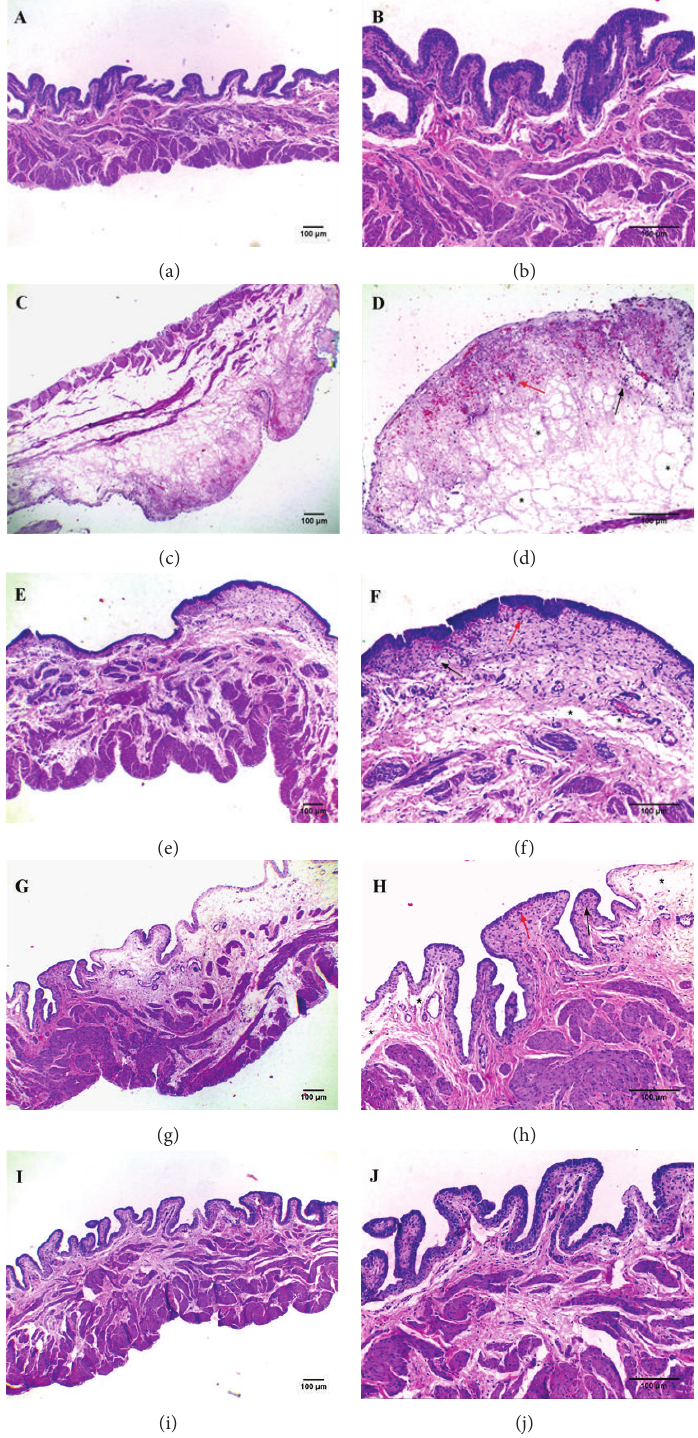
Figure 3: Light microscopy of the bladders of rats with cystitis. Original magnification of 10-fold (Panels (a), (c), (e), (g), and (i)) or 40- (Panels (b), (d), (f), (h), and (j)); hematoxylin and eosin staining. Panels (a) and (b) show control saline + vehicle rats with normal tissue histology. Panels (c) and (d) demonstrate that injection of cyclophosphamide induced mucosal erosion and ulceration, severe edema in the submucosal region ( ∗ ), hemorrhagic foci (red arrows), and leukocyte infiltration (black arrows). Panels (e) and (f) indicate that EECp, at 100 mg/kg, reduced the cyclophosphamide-induced morphological alterations, affecting mainly the leukocyte infiltration and mucosal erosion/ulceration, which was not so clearly observed in the urinary bladders of EECp (400 mg/kg)-pretreated rats (Panels (g) and (h)) that still presented mucosal erosion, ulceration, edema in the submucosal region, and hemorrhagic foci. A slight leukocyte infiltration reduction was observed in these animals ((g) and (h)) when compared with animals pretreated with vehicle and injected with cyclophosphamide ((c) and (d)). Panels (i) and (j) show that mesna pretreatment almost completely reverted the damage induced by